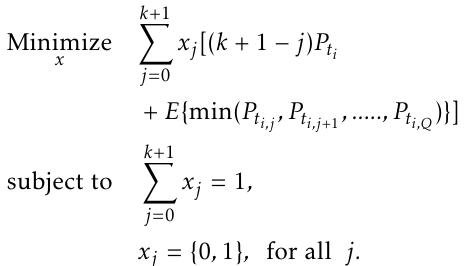
Table 1. THRESHOLDS FOR